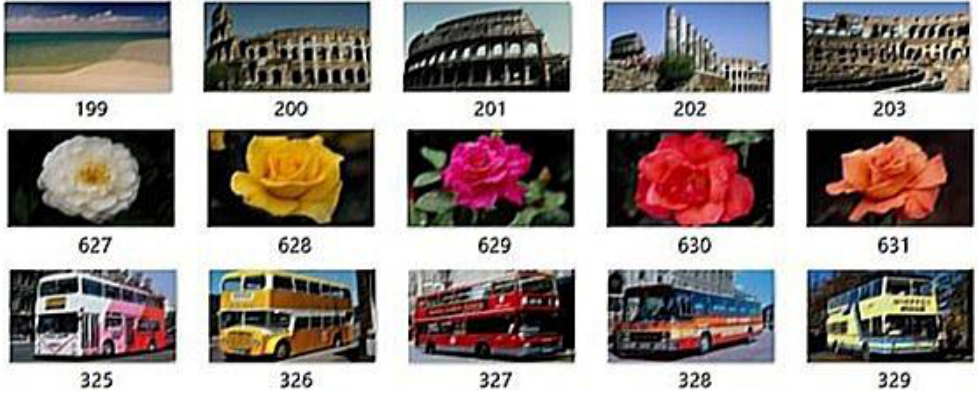
Figure 2. Sample images from the 10 classes of WANG-1000 image dataset.